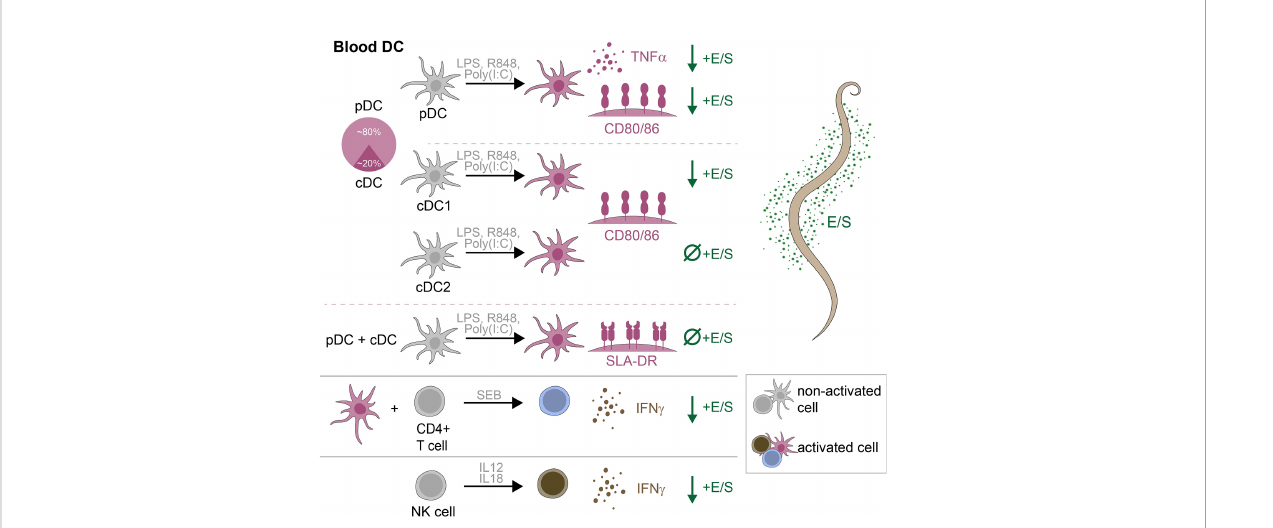
FIGURE 6 Graphical summary of key fi ndings. Within porcine peripheral blood, DC consisted of approximately 80% pDC and 20% cDC. Following stimulation with LPS, R848 and poly(I:C), TNF- a production by pDC, and CD80/86 expression by pDC, cDC1 and cDC2 were signi fi cantly upregulated. With the further addition of A. suum E/S, TNF- a production by pDC, and CD80/86 expression by pDC and cDC1, were signi fi cantly reduced. The addition of A. suum E/S did not reduce expression of CD80/86 by TLR-ligated cDC2, or expression of SLA-DR by any DC subset. When SEB-treated PBMC were co-cultured with autologous TLR-ligand pre-treated DC, CD4+ T cells signi fi cantly upregulated IFN- g production. When DC were pre-treated with E/S in addition to TLR-ligation, this IFN- g production was signi fi cantly reduced. Finally, NK cells treated with recombinant porcine IL-12p70 and IL-18 signi fi cantly upregulated IFN- g production, which was signi fi cantly reduced when cell were treated with E/S in addition to cytokine